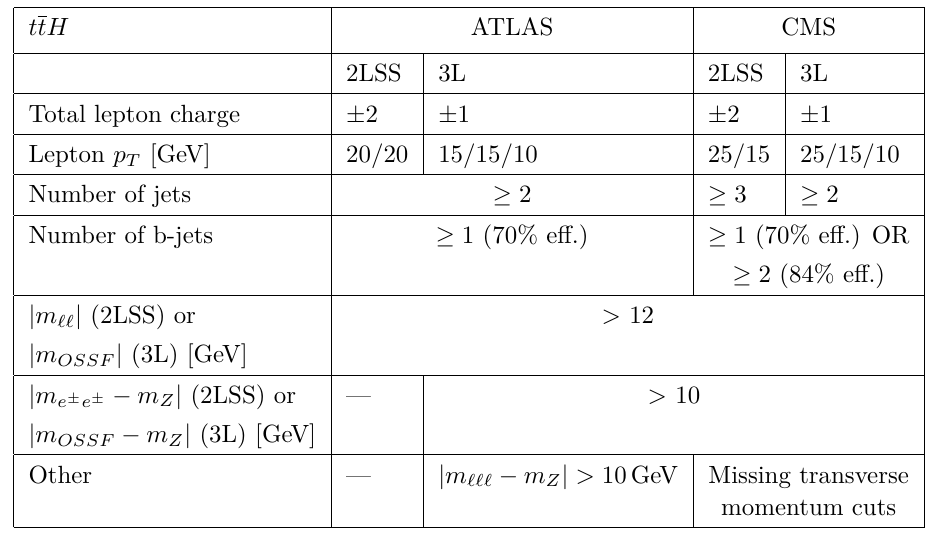
Table 2 . Comparison of event selections between the ATLAS [3] and CMS [4] ttH